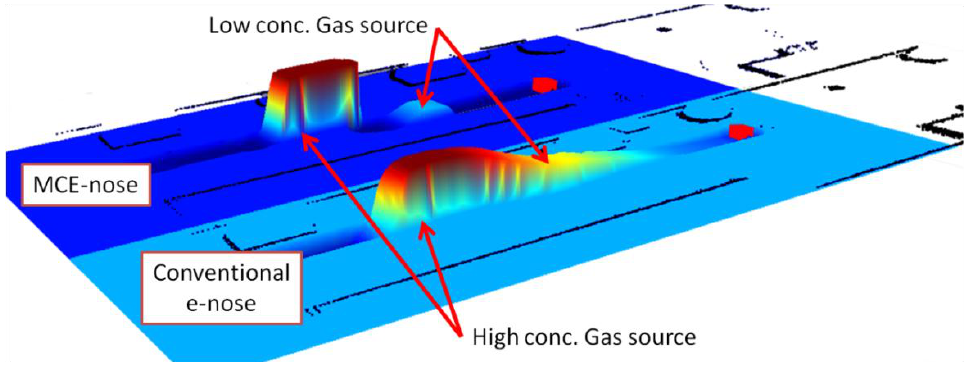
Figure 16. 3D comparison of the ICP SLAM generated maps between a conventional e-nose and the MCE-nose when faced to two gas sources of different